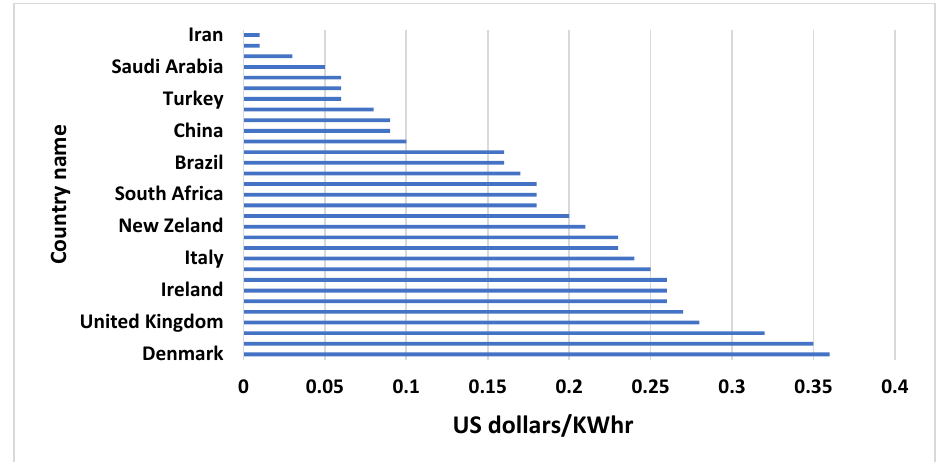
Figure 3. Electricity tariff pricing in different countries in 2021.